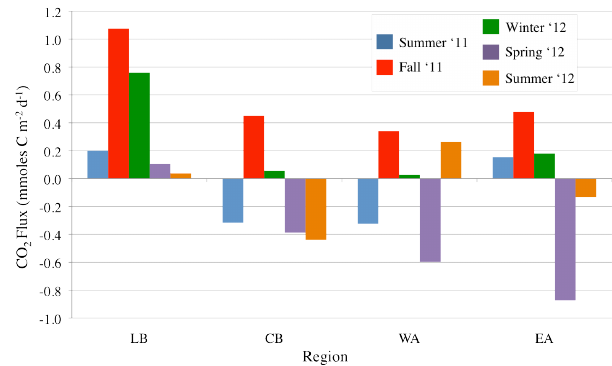
Figure 7. Seasonal air–sea CO 2 fluxes by region in mmolCm − 2 d − 1 . Blue: summer of 2011; red: fall of 2011; green: winter of 2012; purple: spring of 2012, yellow = summer of